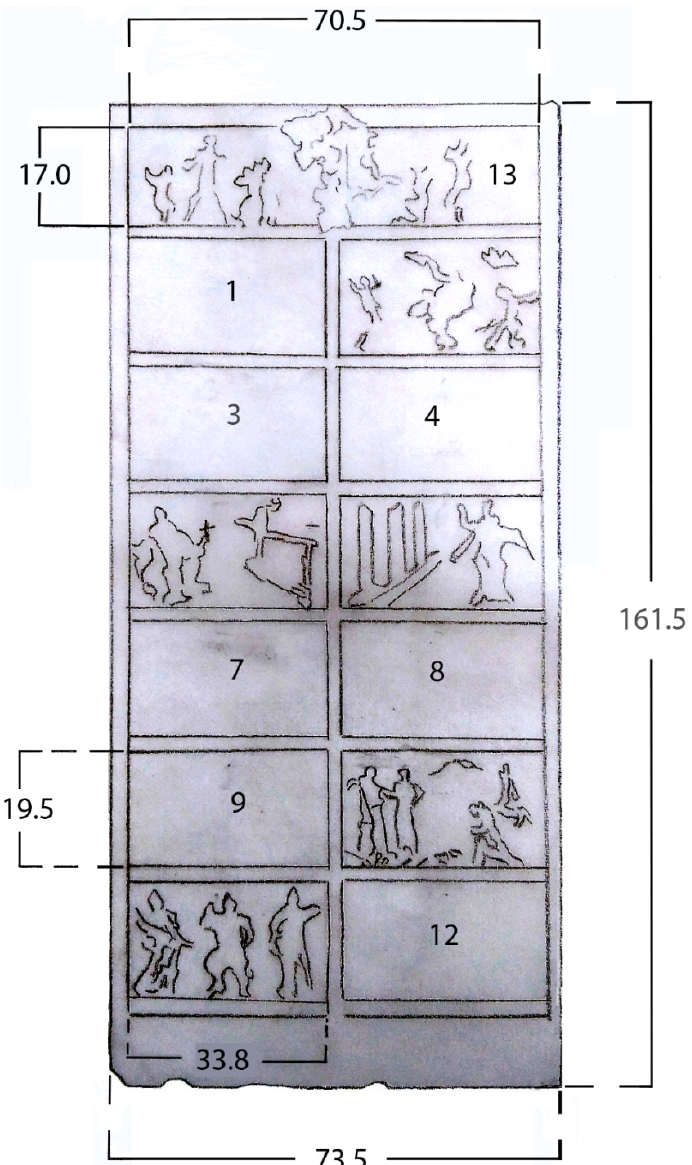
Figure 1. Schematic drawing of the fifth door of the Milan Cathedral, Lucio Fontana 1955–1956. Sizes are in centimeters. Tile 1: Tedeum liberation of Milan; tile 2: Archbishop Schuster among the victims of the bombing; tile 3: The plague; tile 4: Coronation of Napoleon; tile 5: Martin V and the high altar; tile 6: Saint Carlo consecrates the Cathedral; tile 7: Volunteering; tile 8: Marble transport; tile 9: Gian Galeazzo Visconti and the Milanese, the offerings; tile 10: Archbishop Antonio da Saluzzo promulgates the bull of foundation of the Cathedral; tile 11: The six Milanese popes (1); tile 12: The six Milanese popes (2); tile 13: The prayer of the city of Milan to the Virgin.